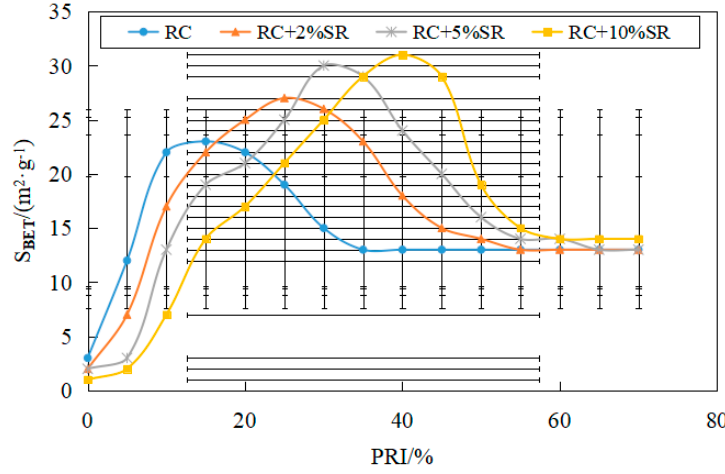
Figure 13. Effect of soda residue on specific surface area after coke reaction.